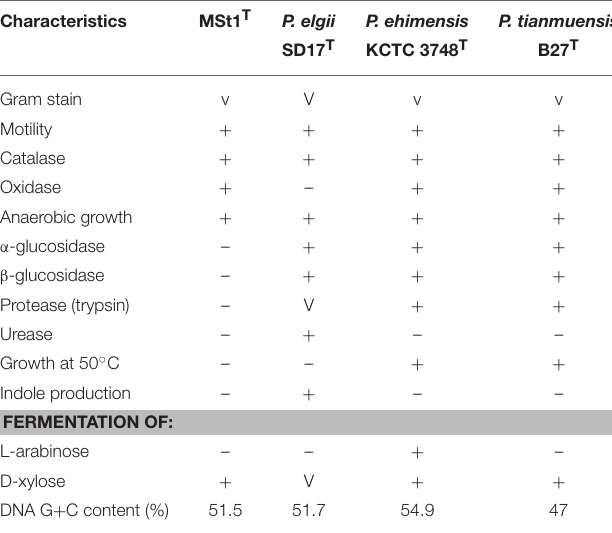
TABLE 1 | Distinctive phenotypic characteristics of strain MSt1 T when compared to its closely related type species of Paenibacillus. Characteristics